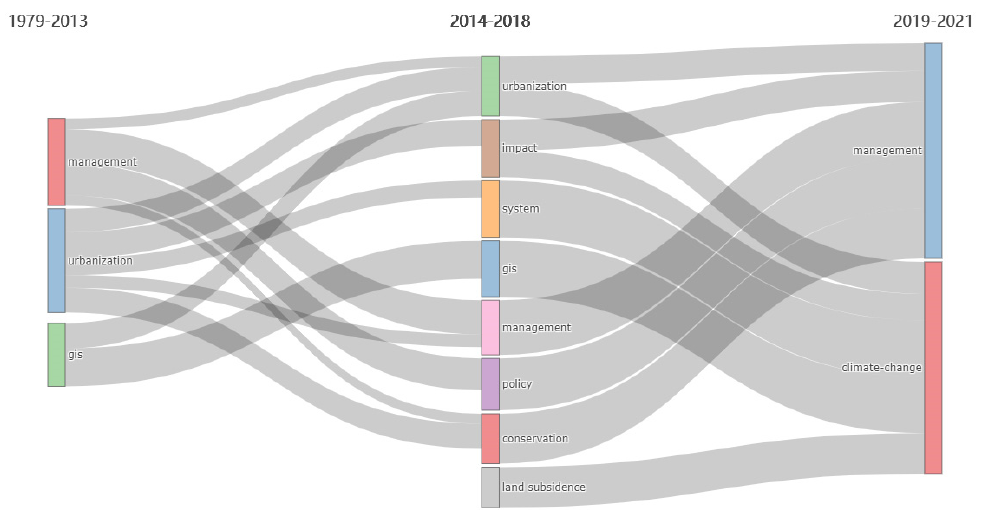
Figure 11. Thematic evolution in the field of urban land management (1979–2021).